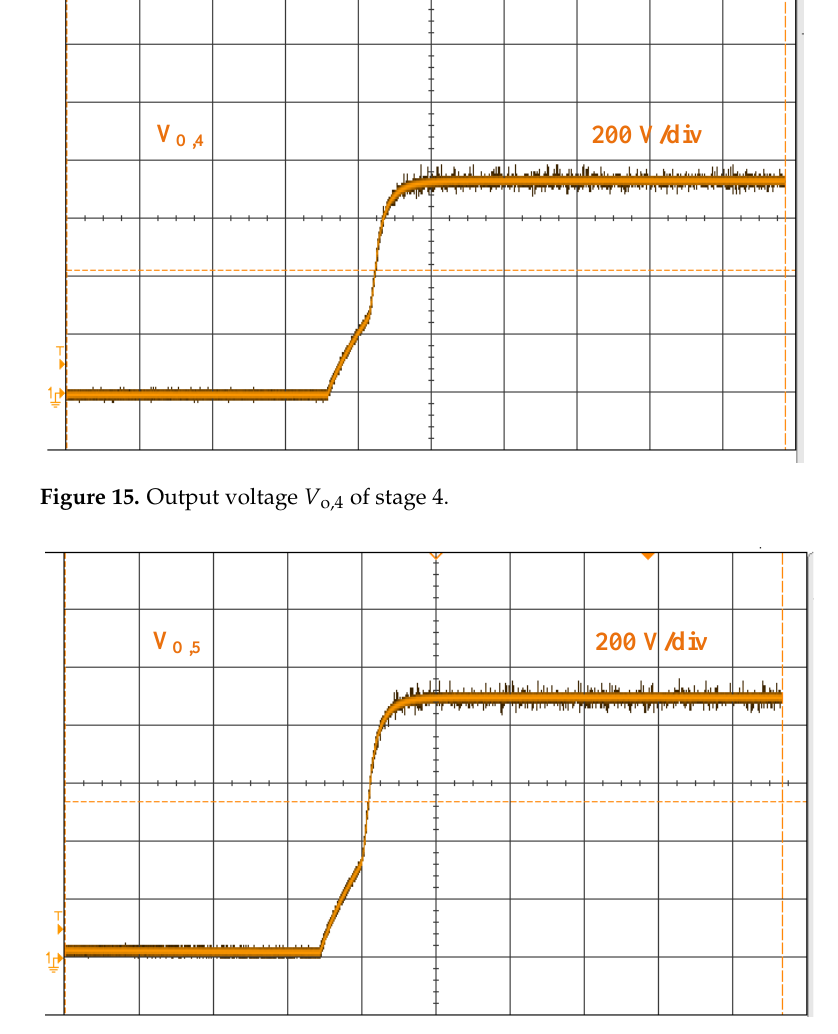
Figure 16. Output voltage V o,5 of stage 5.